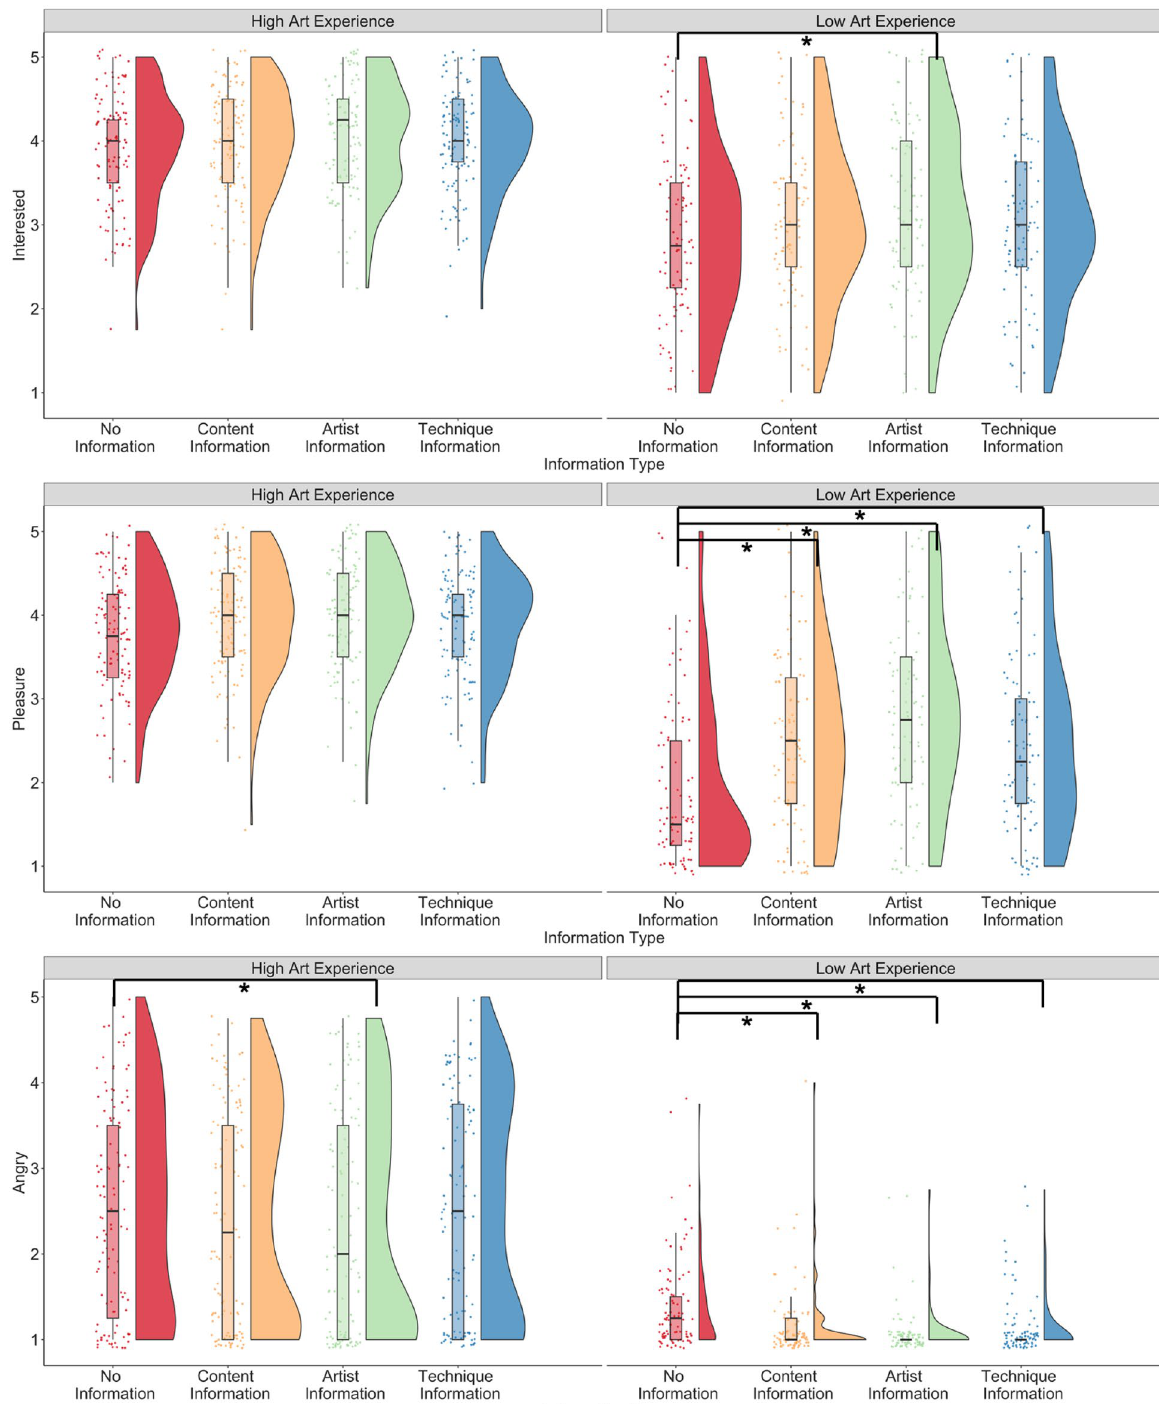
Figure 7. Interest, pleasure, and angry ratings when no information, content information, artist information, and technique information was presented to participants, split by participants with high and low art experience. *p <